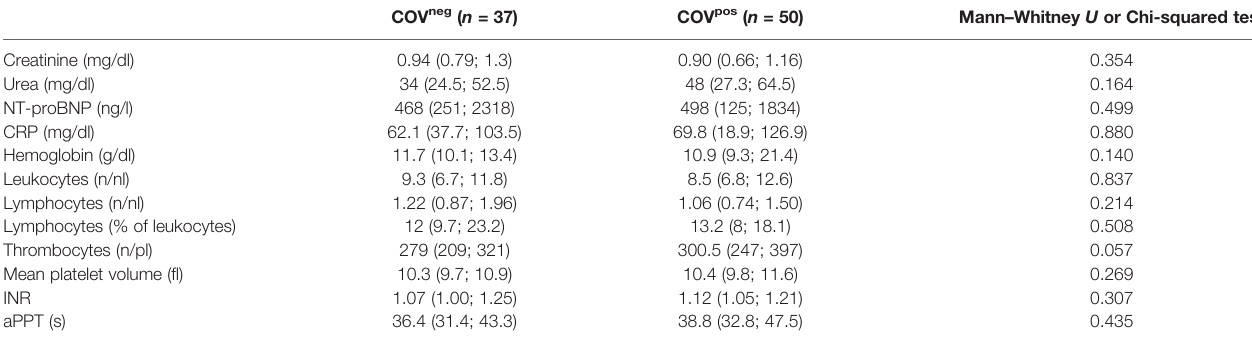
TABLE 3 | Patient characteristics — laboratory values.